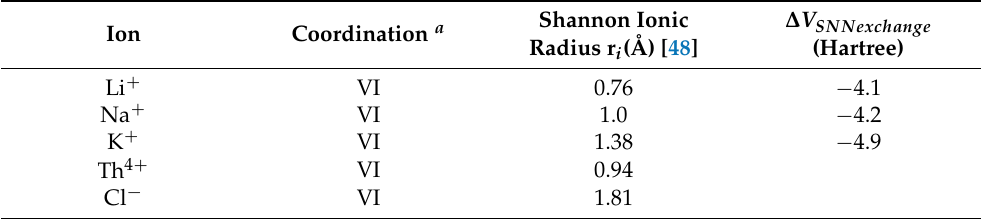
Table 5. Change in exchange energy due to SNN exchange